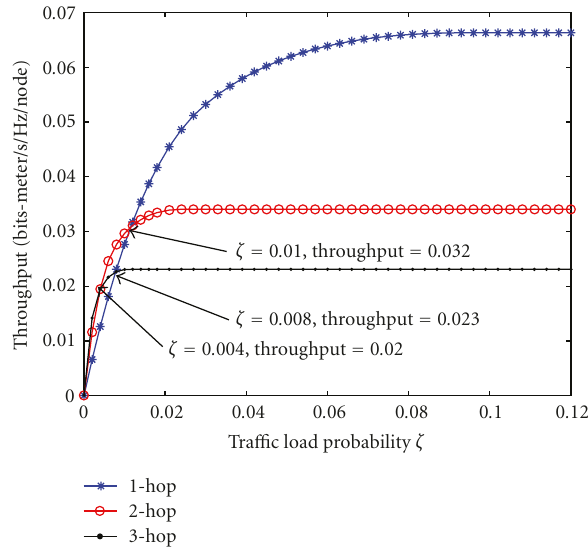
Figure 7: Throughput of ALOHA with di ff erent transmission ranges: 1-hop, 2-hop, and 3-hop ranges. We used ρ = 1, square topology, and SISO channels. The transmission power for each of the three cases is adjusted so that the SNR (excluding interference) at every receiver is